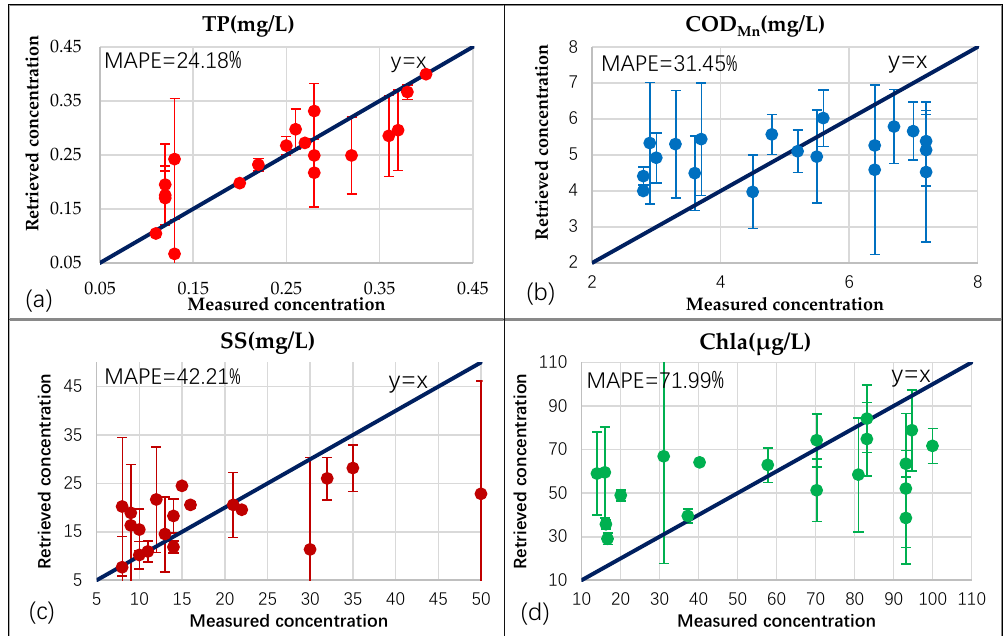
Figure 15. Measured and retrieved concentrations (using GF-1 remote sensing data) and the mean absolute percentage error (MAPE) of water quality components at each sampling site: ( a ) TP, ( b ) COD Mn , ( c ) SS, ( d ) Chla.